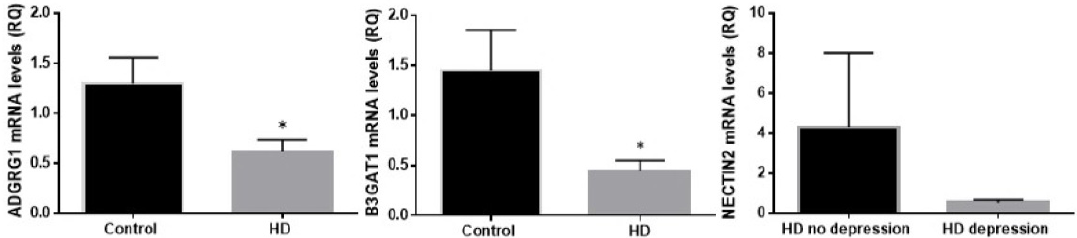
Figure 1. mRNA levels of the top three differentially expressed genes. *: p < 0.05.